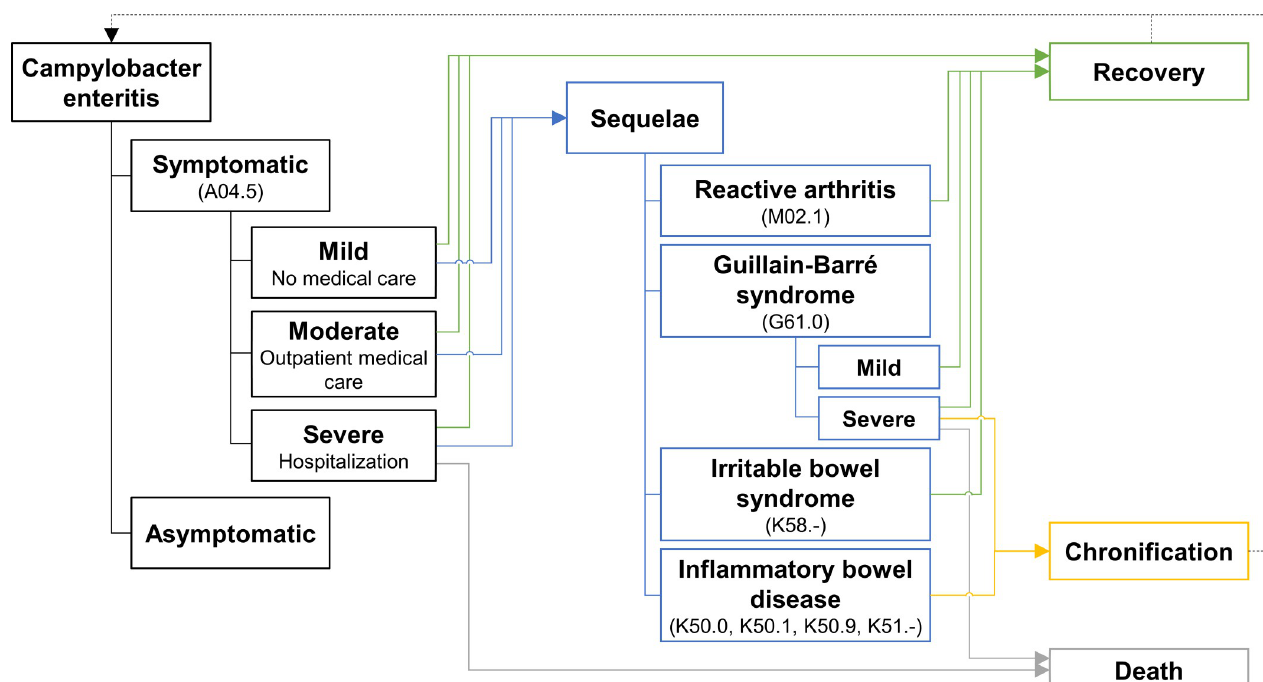
Fig 1. Disease model of Campylobacter enteritis and sequelae. Disease model based on established models [10, 11]. ICD-10 codes are shown in parentheses.